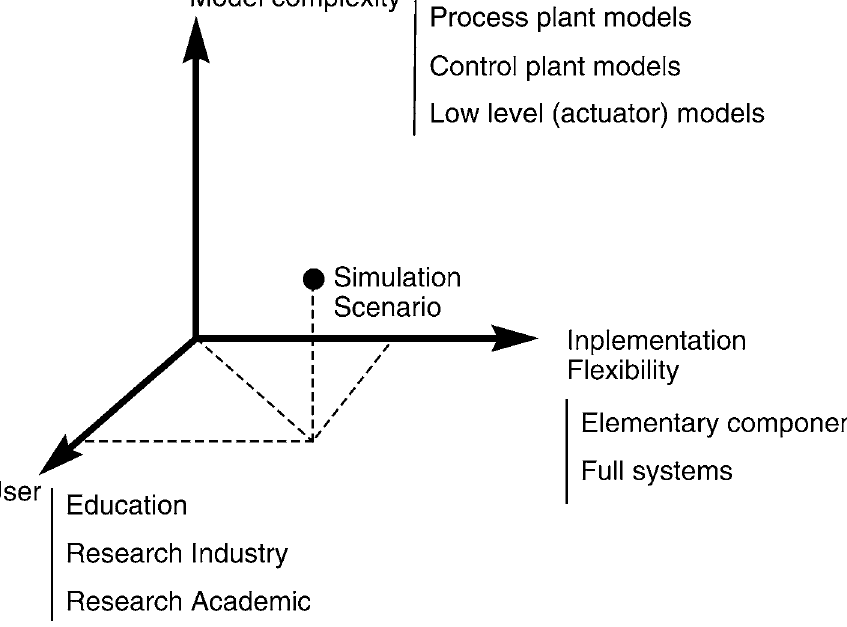
Figure 1. Simulation scenario